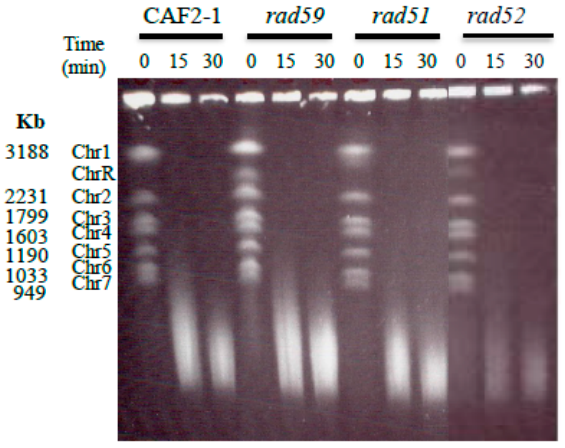
Figure 2. Determination of chromosome breaks (HDBs) following acute MMS treatments. Cells from wild type CAF2-1 and the several HR mutant derivatives were treated with 0.05% MMS for 15 and 30 min, followed by immediate DNA purification and pulse-field gel electrophoresis (PFGE).